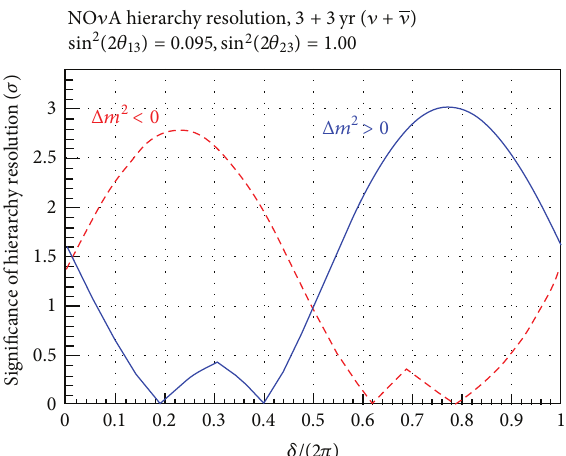
Figure 30: Biprobability plot for sin 2 (2𝜃 23 ) = 0.97 with NO 𝜈 A extrapolated to the average oscillation phase of T2K.